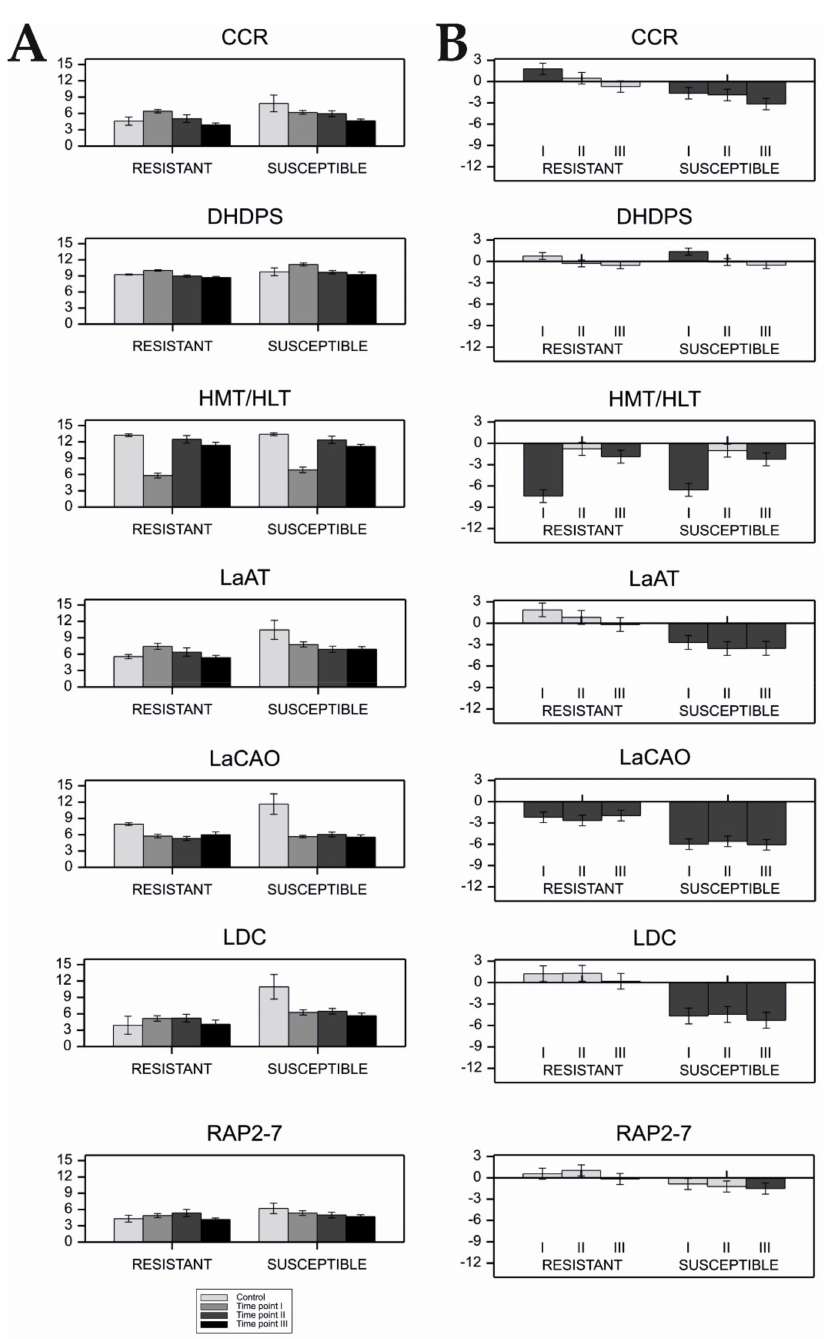
Figure 4. The expression pattern of alkaloid (QA) genes measured during Colletotrichum lupini infection in two groups of narrow-leafed lupin cultivars with different infection resistance levels. Plants mildly affected by the disease are referred to as ‘resistant’ (four cultivars), while plants severely affected by the disease are referred to as ‘susceptible’ (four cultivars). Full names of genes are listed in Table 1. ( A ) QA gene expression measured in control plants and at three time-points during Colletotrichum lupini infection (48 h, 72 h, and 120 h after inoculation). Log 2 -transformed mean values and standard errors are depicted. ( B ) FC values for QA gene expression at consecutive time-points of infection (I–III) in comparison to the control. Dark grey bars indicate statistically different expression ( p < 0.05). Bars above the x-axis represent increased expression and those below the x-axis represent decreased expression after infection. FC of expression is shown in log 2